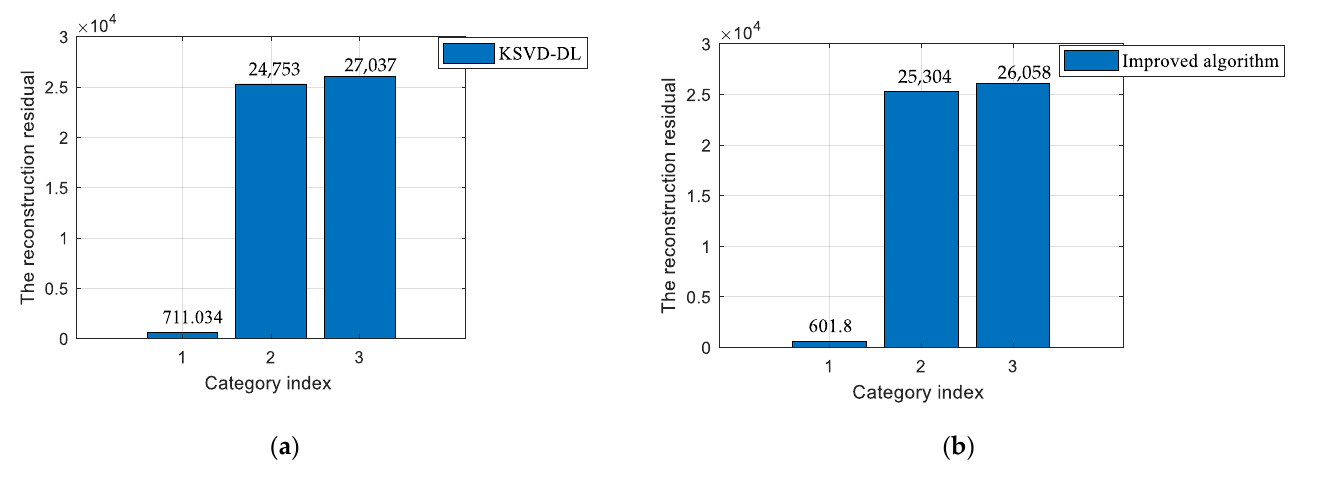
Figure 15. The comparison results between the improved method and other methods. ( a ) The residual of the KSVD-DL algorithm. ( b ) The residual of the improved algorithm.